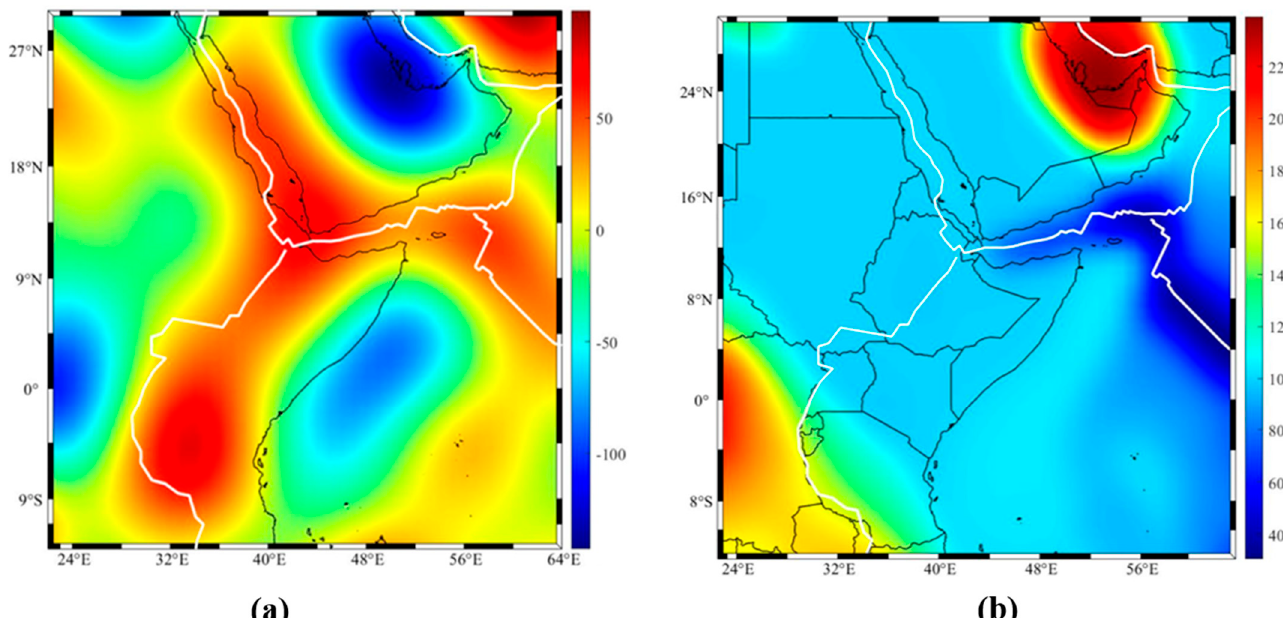
Figure 3. ( a ) Disturbing potential [m 2 s − 2 ] (GOCE TIM R6, degree 13 to 25) over the study area compared to the plate boundary (shown in white line). ( b ) Lithospheric depth (km) of the study area according to [36]. White lines are the boundaries of the plates from model PB2002 [26].